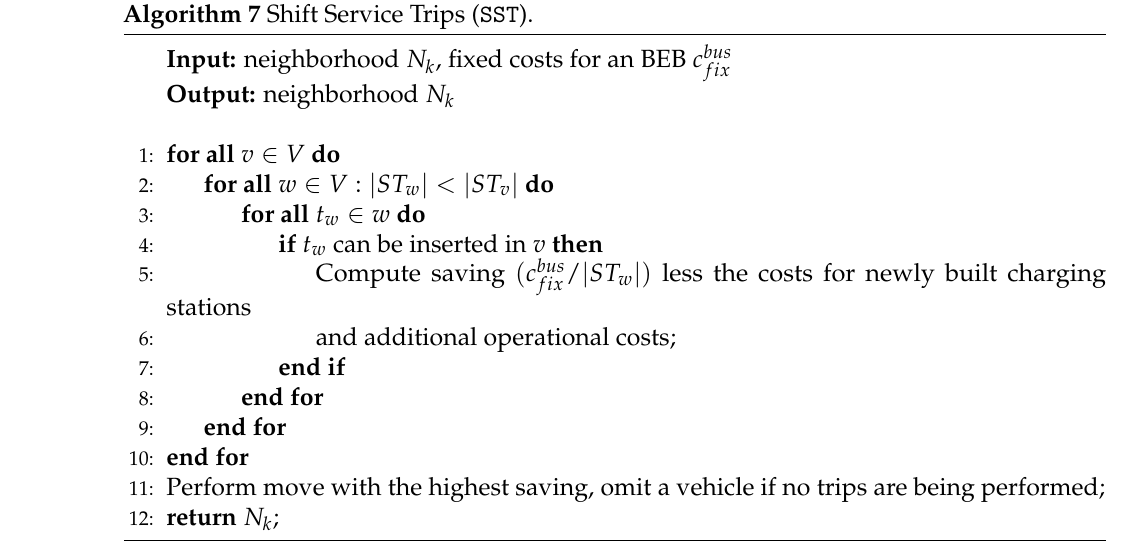
Algorithm 8 aims at decreasing the number of charging stations used by moving charging procedures from less frequented charging stations to higher frequented charging stations, considering the vehicle rotations of a neighborhood. The move is returned that is feasible and entails the highest saving including proportionate fixed costs for remaining